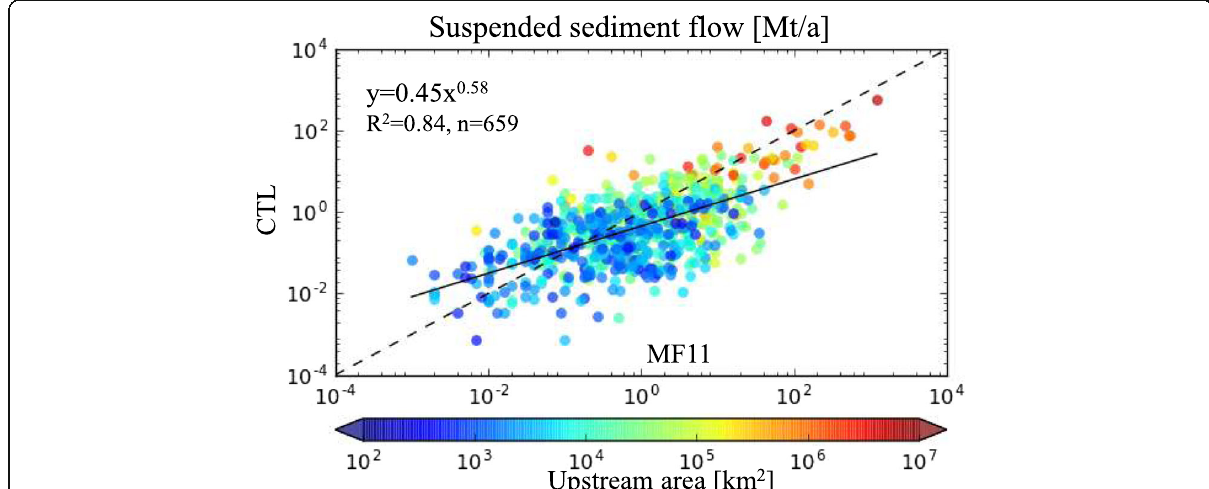
Fig. 8 Scatter plot of annual suspended sediment flow [Mt/a] between MF11 and CTL. The colors of each plot indicate the river basin area. The solid and dashed line indicate the trend and 1:1 line,